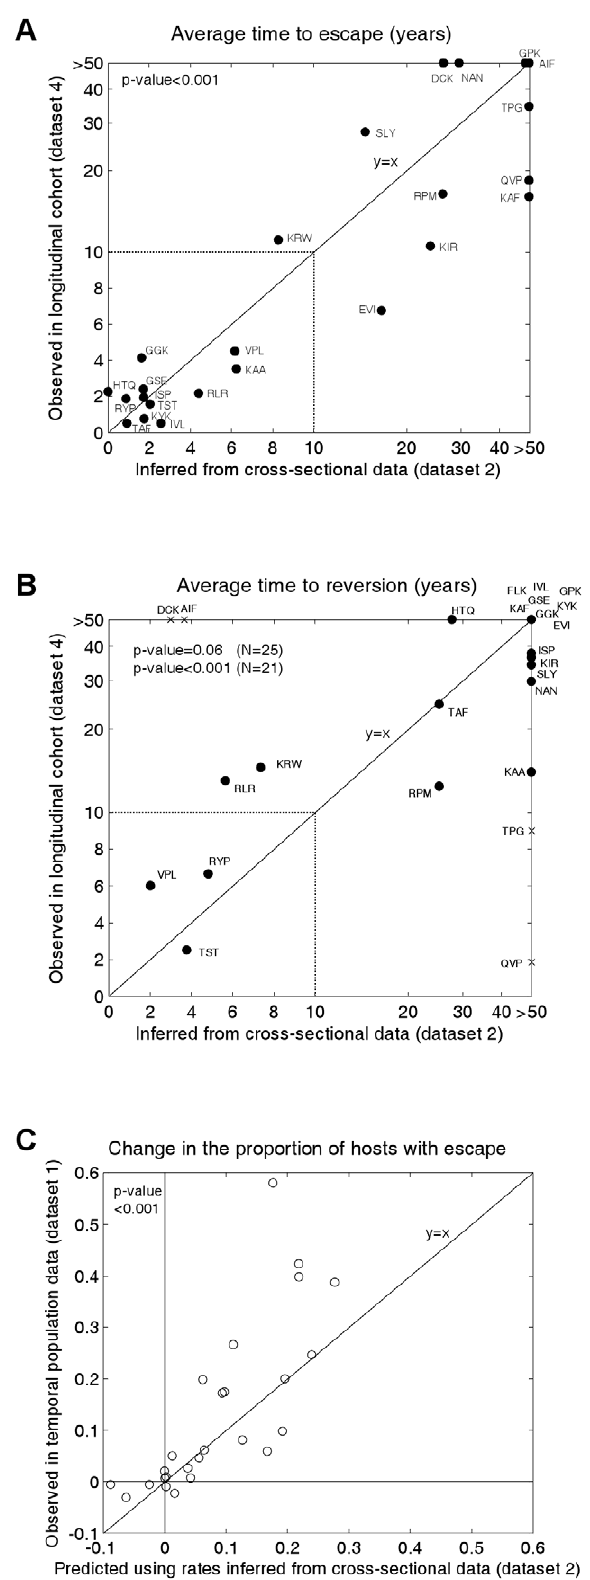
Figure 3. Observed and inferred escape rates, reversion rates and changes in escape prevalence. A) A comparison of the mean times to escape inferred from dataset 2, the cross-sectional data (x-axis) and observed in dataset 4 (Figure 2E), the longitudinal cohort study